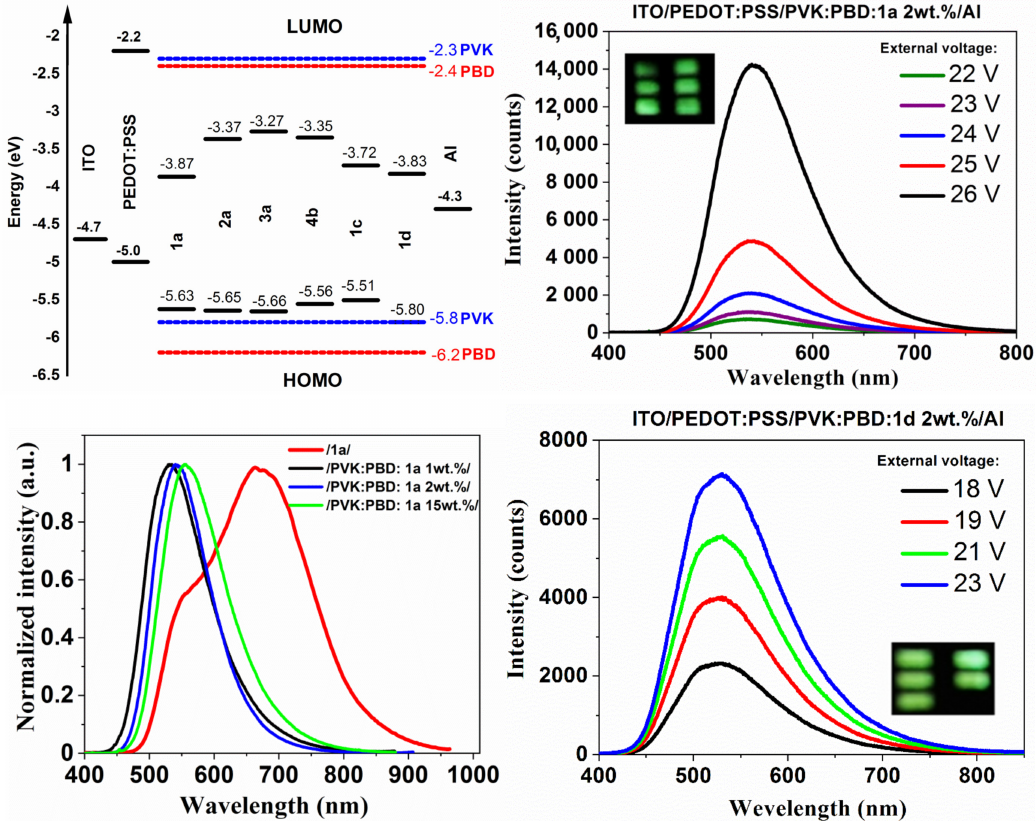
Figure 6. Diagram of HOMO and LUMO energy levels of diode components and EL spectra of the working devices under an applied voltage with their photo. Only two devices, which the bis-(imino-1,8-naphthalimides) acts as an active layer, with the molecules 4b and 1d, did not show electroluminescence, for other diodes the